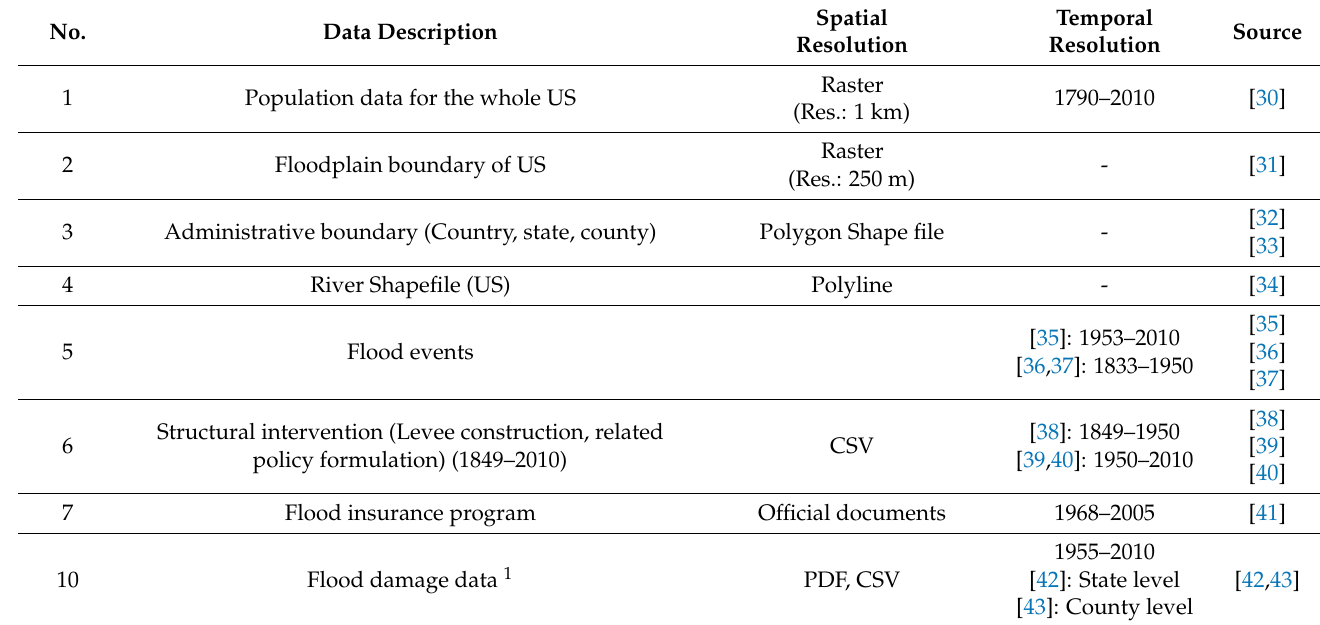
Table 1. Datasets used for spatial and temporal analysis of floodplain population dynamics, historical flood events, and intervention